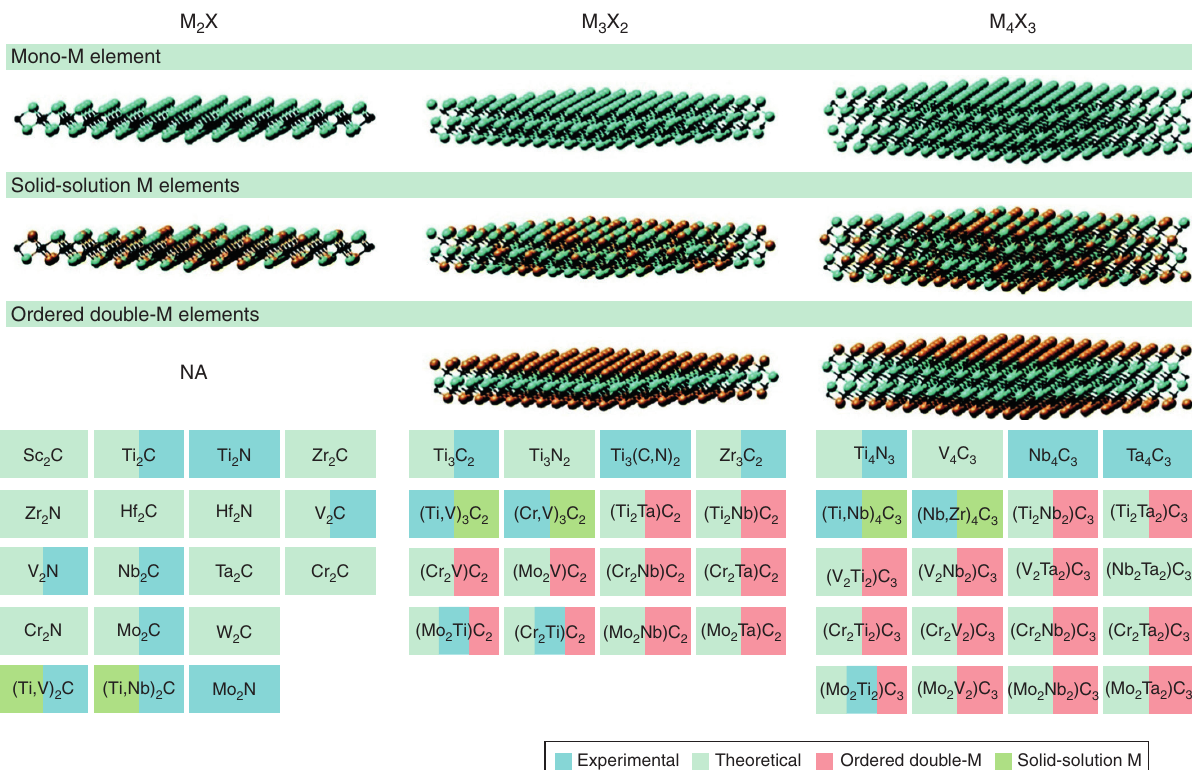
X, M X , and M X , where M stands for early transition metal and 2 3 2 4 3